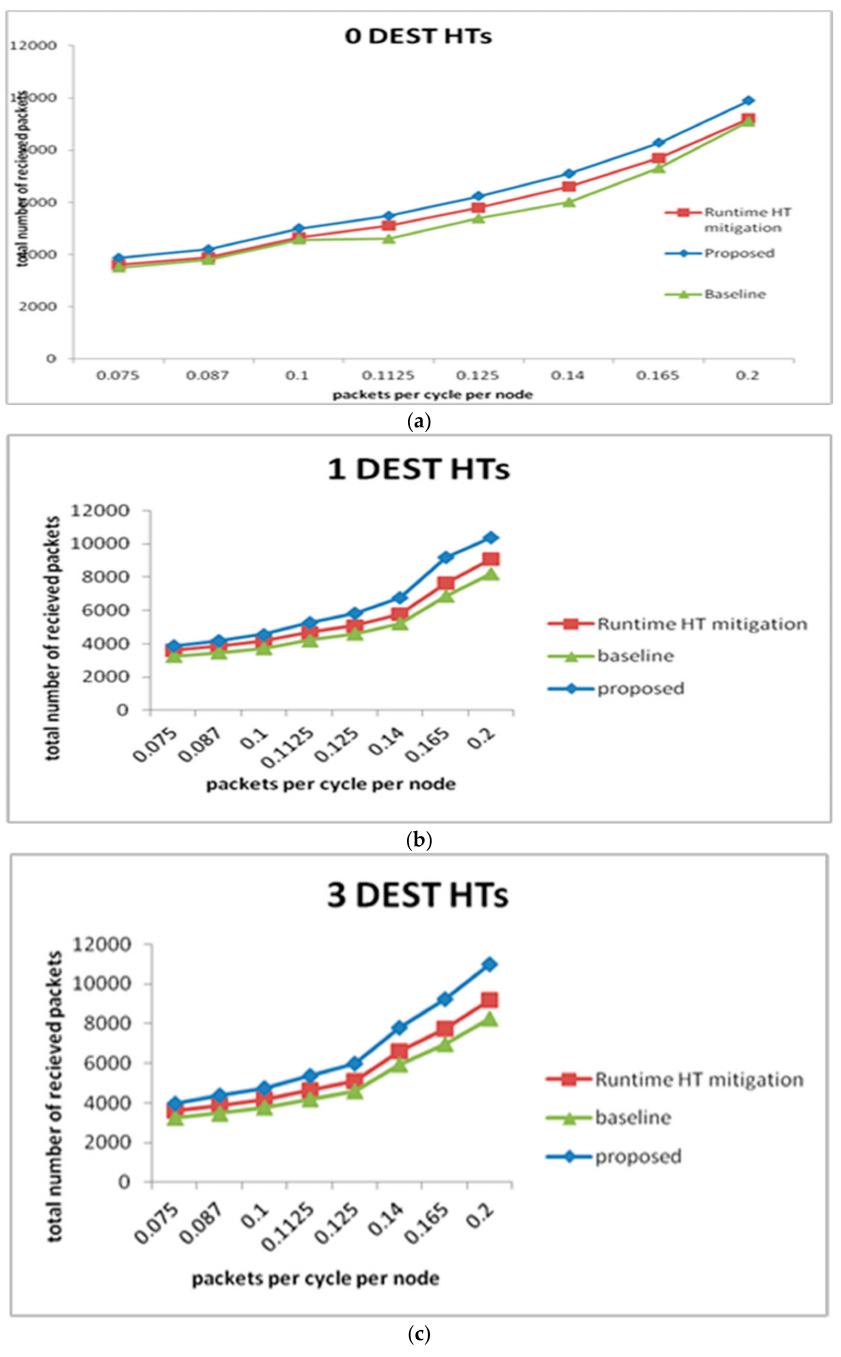
Figure 9. ( a ) No HT. ( b ) One dest HT. ( c ) Three dest HTs. The amount of acknowledged valid packets impacted by the HEAD HTs is